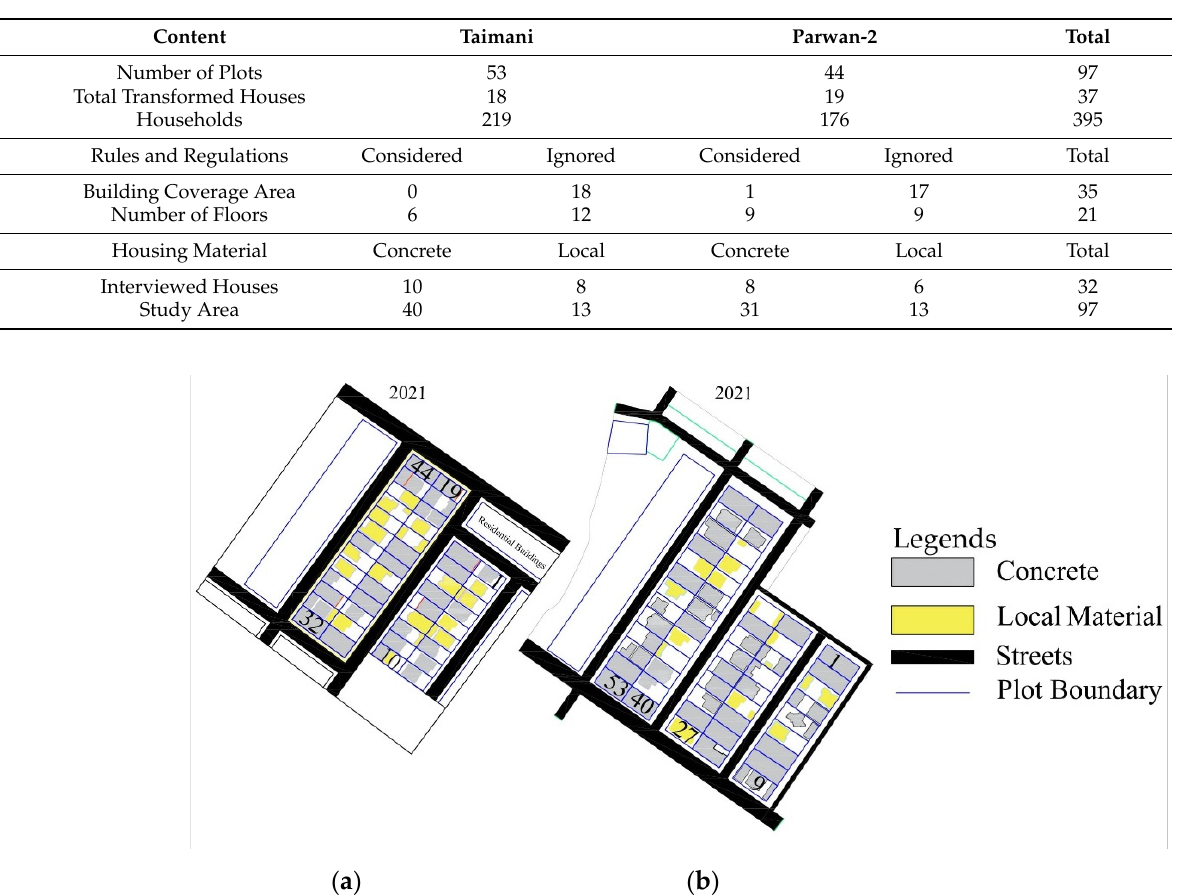
Table 2. Statistic of Transformed Houses in Study Areas.